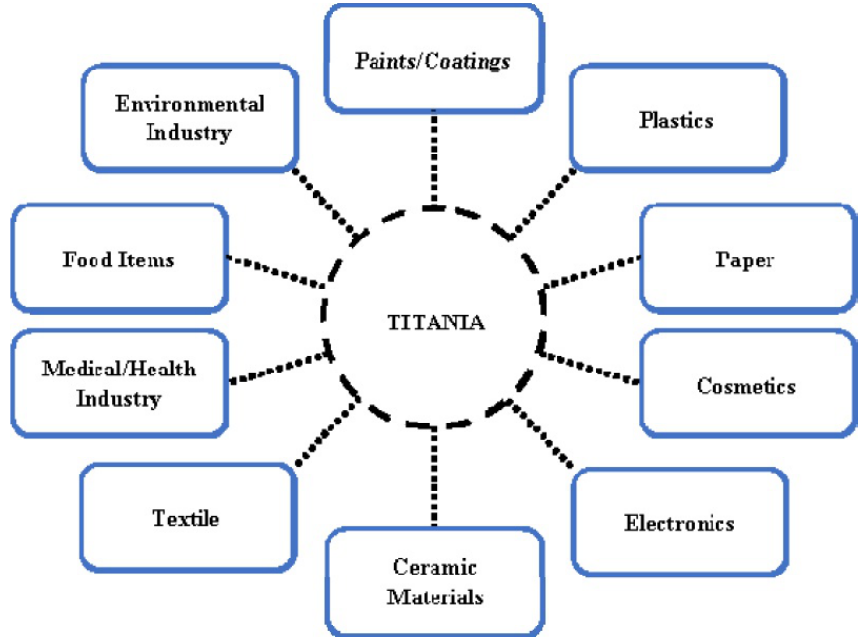
Fig. 8. Application areas of Table 2. Industrial applications of NTPs.